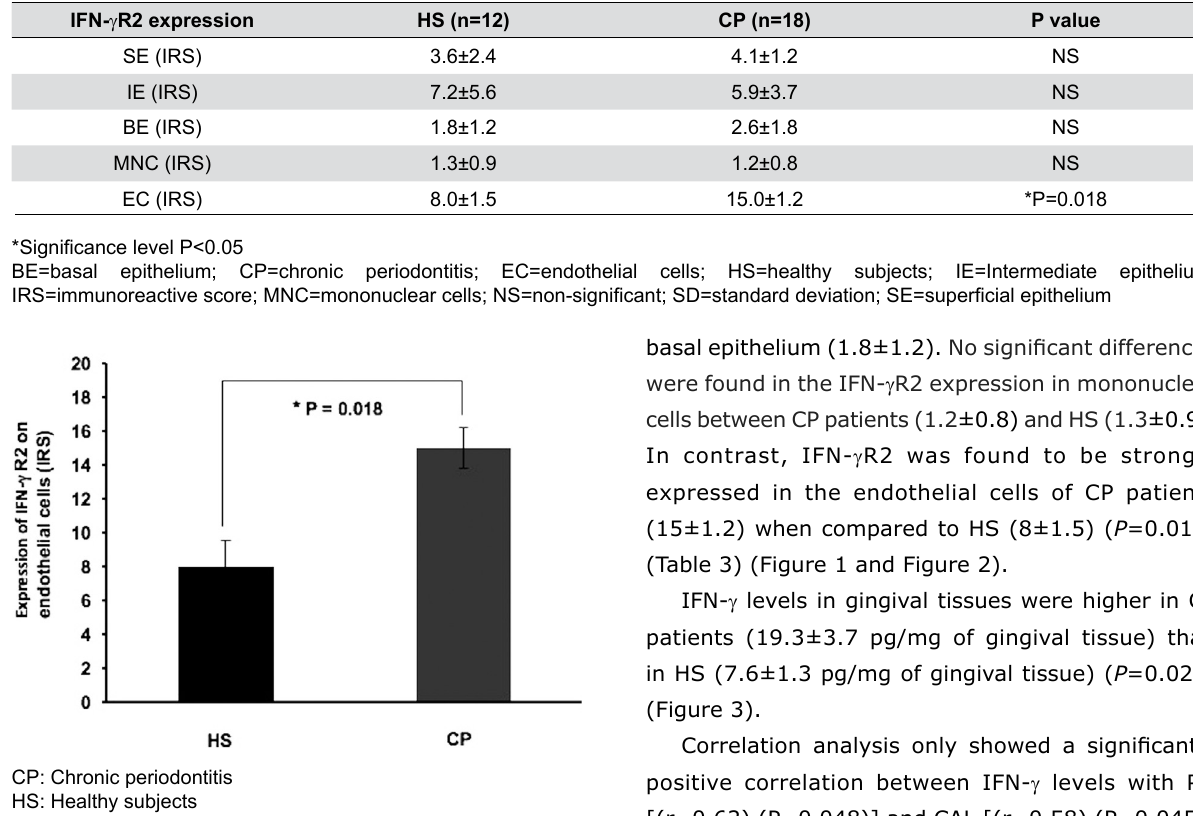
Table 3- IFN- g R2 expression in epithelium and stroma of healthy subjects (HS) and patients with chronic periodontitis (CP)